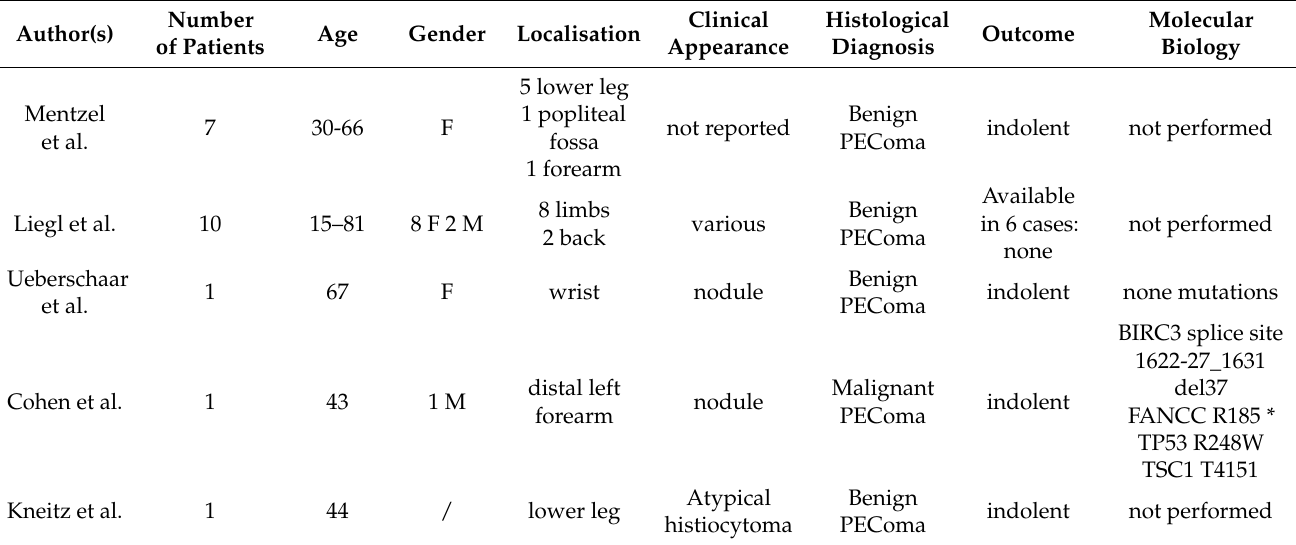
Table 2. Some examples of cPEComas reported in the